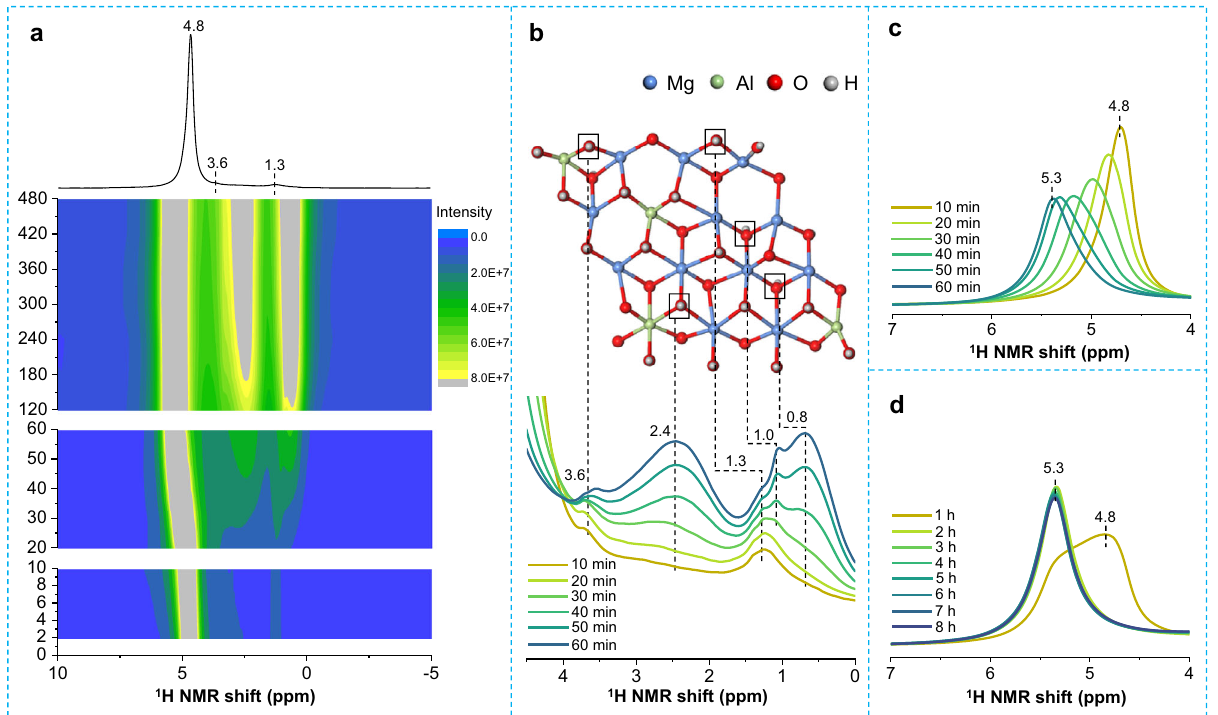
Fig. 6 | In situ 1 H NMR spectra of rehydrated Mg/Al-LDO. a 2D in situ 1 H MAS NMR spectra of rehydrated Mg/Al-LDO (massratio of LDO to D 2 O is1:1). The 1D spectrum shown on top corresponds to a rehydration time of 2min. Each spectrum during rehydration time t = 2 − 10min, 10 − 60min and 2 − 8h takes ~2min, 10min and 1h to collect, respectively, by adjusting the acquisition